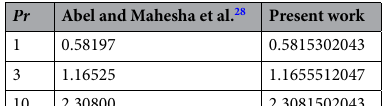
Table 3. Numerical validation for heat transfer rate when ϕ 1 = 0, ϕ 2 = 0, ϕ 3 = 0.